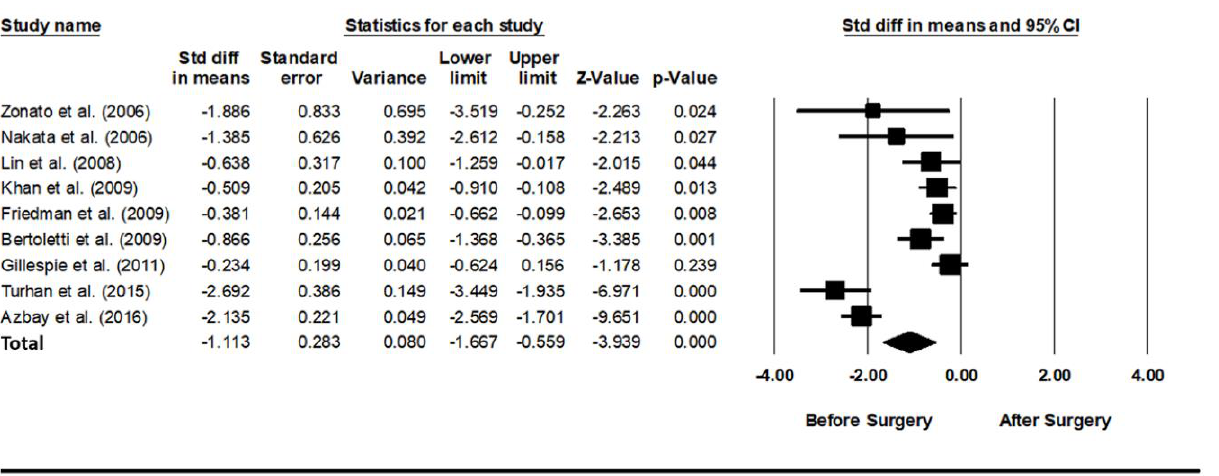
Figure 2. Forest plot for the effects of pharyngeal obstructive sleep apnea surgery on the optimal positive airway pressure level. The summed optimal PAP level was significantly lower after pharyngeal OSA surgery than before surgery. Std diff, standardized difference; CI, confidence interval [26–34].